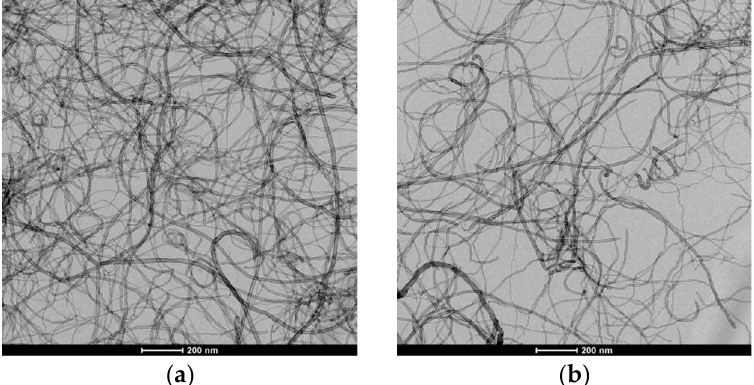
Figure 1. TEM images of: ( a ) oxMWCNT3h and ( b ) oxMWCNT6h.